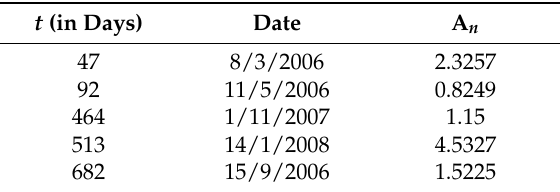
Table 11. Change points in the estimated positive jump time series of Google with the corresponding test statistic value.